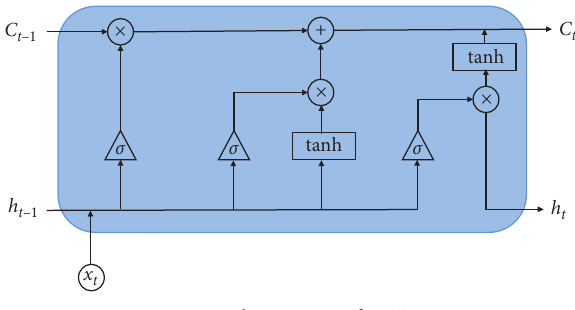
Figure 2: Internal structure of LSTM